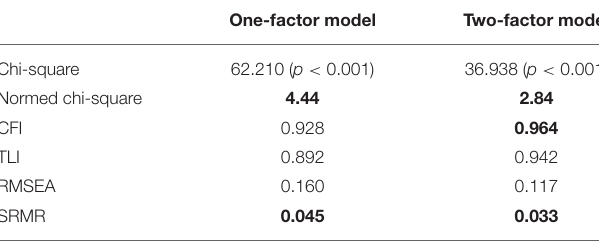
TABLE 4 | Results from confirmatory factor analysis.